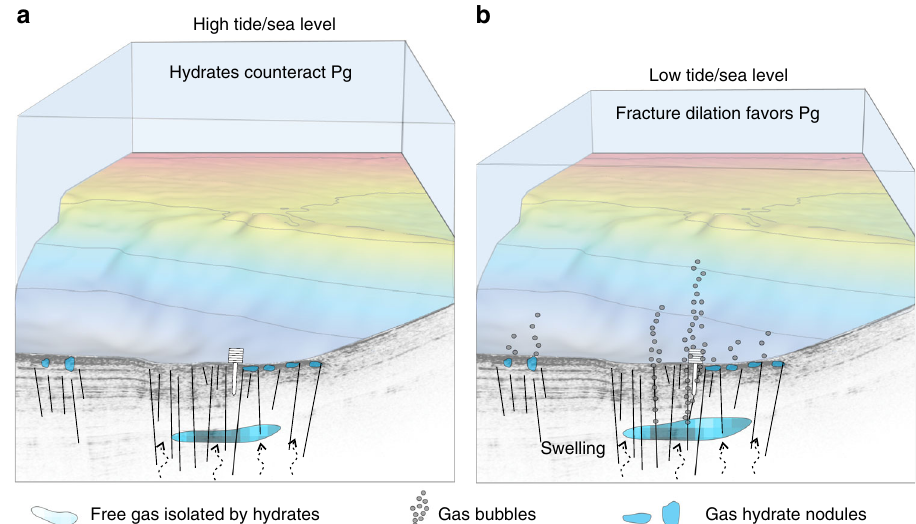
Fig. 7 Conceptual model of gas emissions. Schematic model showing how gas emissions may be affected by tides through fracture opening. a At high tides the system is under a balanced pressure fi eld. b At low tides (<1 m water column height decrease) a subtle fracture dilation would shift the pressure fi eld to favor gas advection and seepage. P g stands for free gas